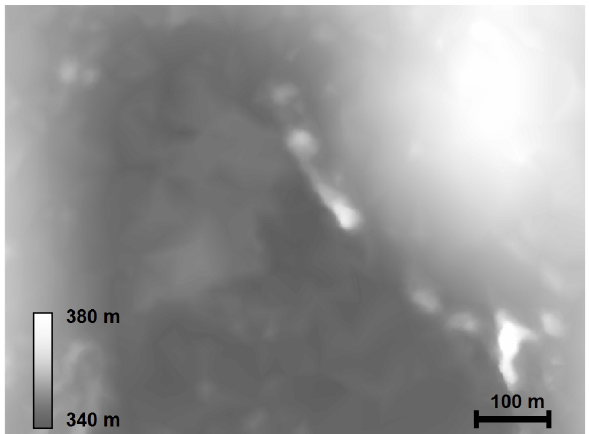
Figure 8. Digital Surface model derived from the UAS images in a resolution of 1 m x 1